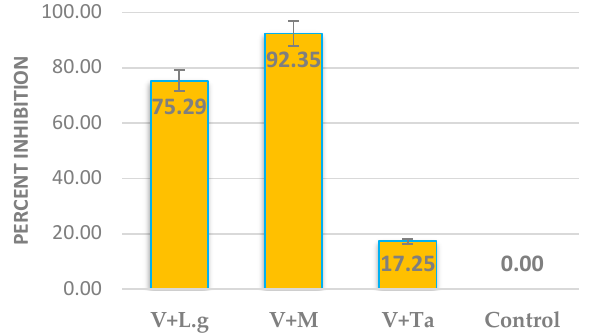
Figure 2. In vitro efficacy of VOCs immobilized vermiculite ball using olfactory chamber, V— Vermiculite, L.g— C. citratus , M— M. spicata , Ta— Trichoderma asperellum.